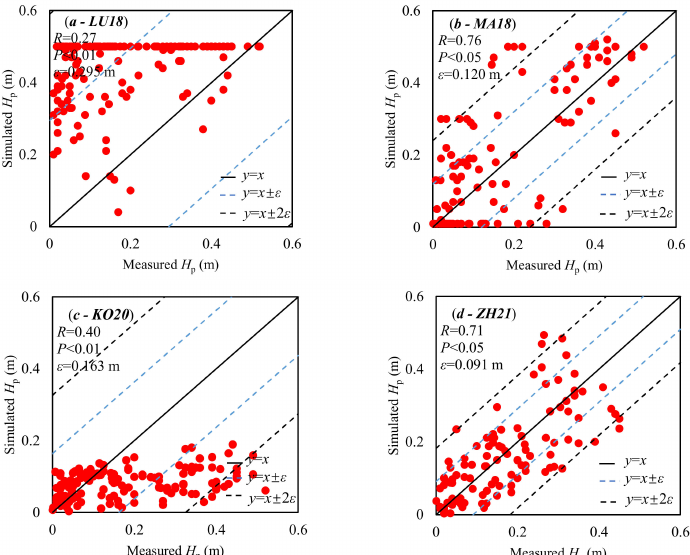
Figure 2. Comparison between the in situ measured H p and the estimations by the above four algorithms under overcast sky conditions. Panel ( a ) is the results for the LU18 algorithm, ( b ) for the MA18, ( c ) for KO20 and ( d ) for ZH21. R is the correlation coefficient. P is the significance level of the correlation. ε is the root-mean-square error.